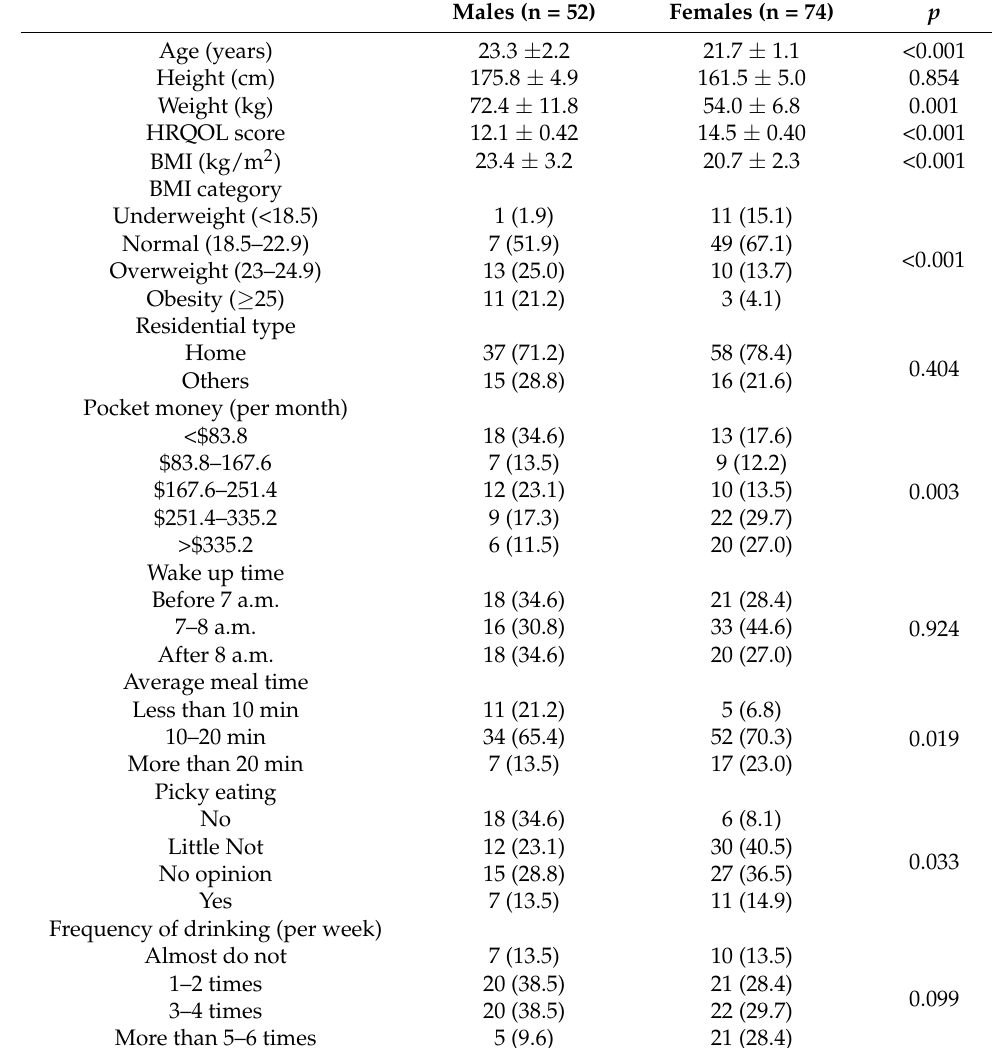
Table 1. General characteristics of